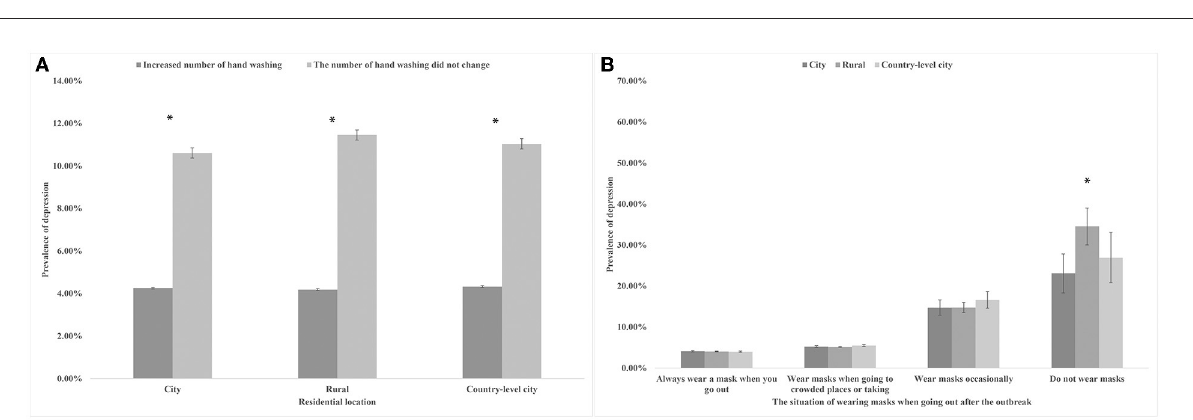
FIGURE2 (A) The prevalence of depression symptoms in participants by degree of handwashing and residential location. * P < 0.05. (B) The prevalence of depression symptoms in participants by degree of wearing masks and residential location. * P < 0.05.